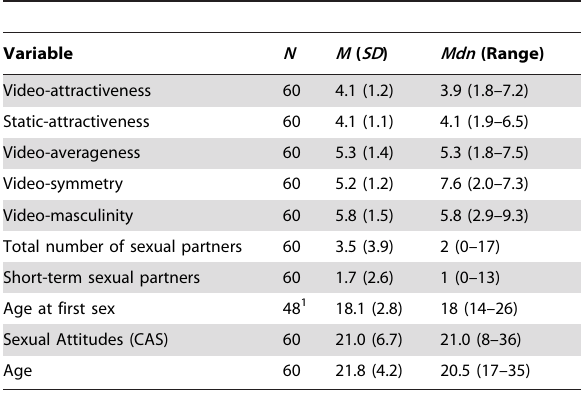
Table 1. Descriptive statistics for appearance ratings, mating success variables, attitudes and age.